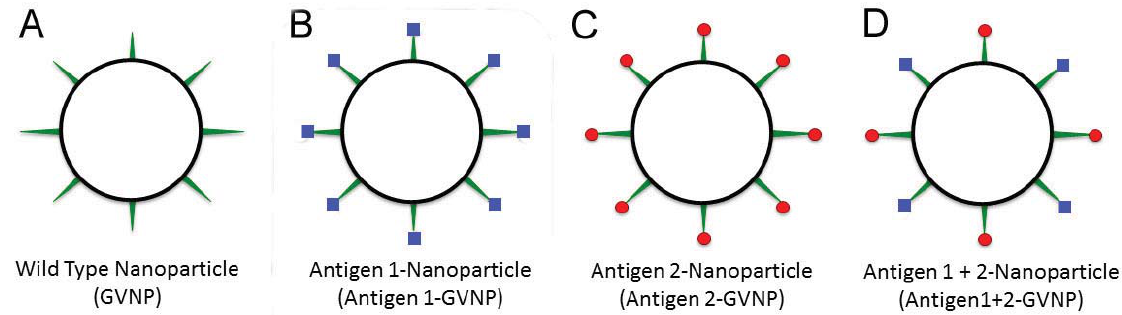
Figure 3. Antigen display employing GVNPs. Wild-type GVNPs (black circle, ( A )) can be engineered to display, via fusions to GvpC (green spikes), different antigens (blue squares or red balls) separately ( B , C ) or together ( D ) on